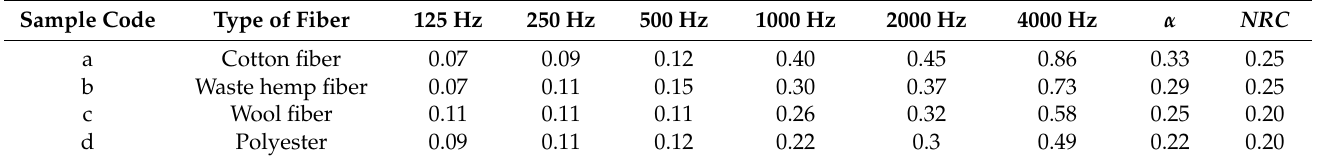
Table 4. Average sound-absorbing coefficient, noise reduction coefficient, and sound absorption coefficient of fiber aggregates at each